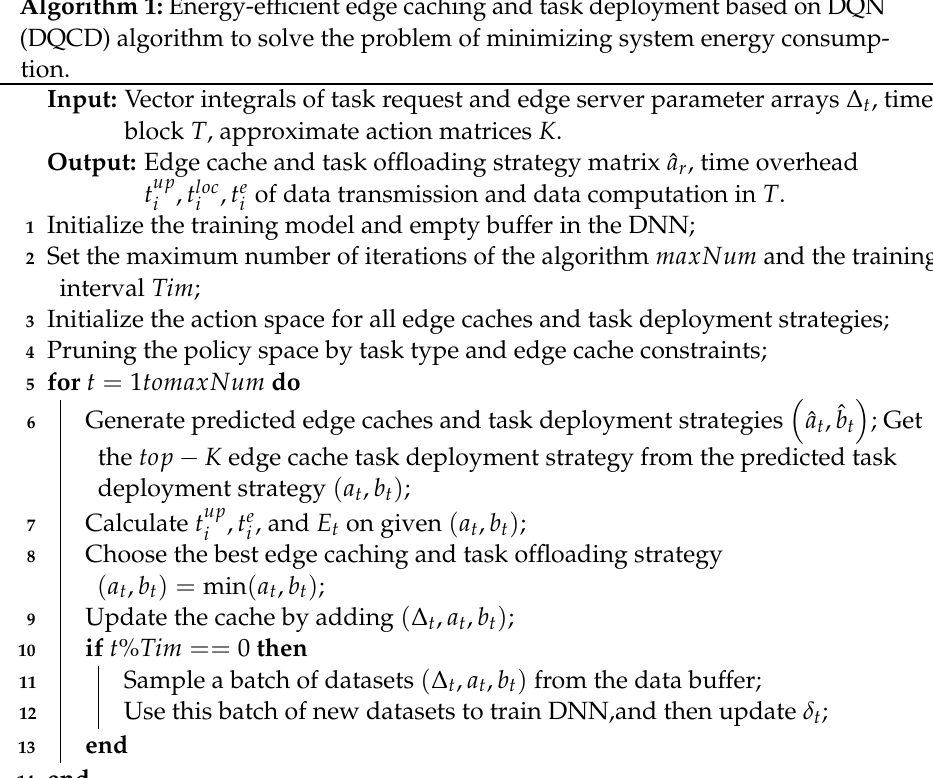
Algorithm 1: Energy-efficient edge caching and task deployment based on DQN (DQCD) algorithm to solve the problem of minimizing system energy consump-